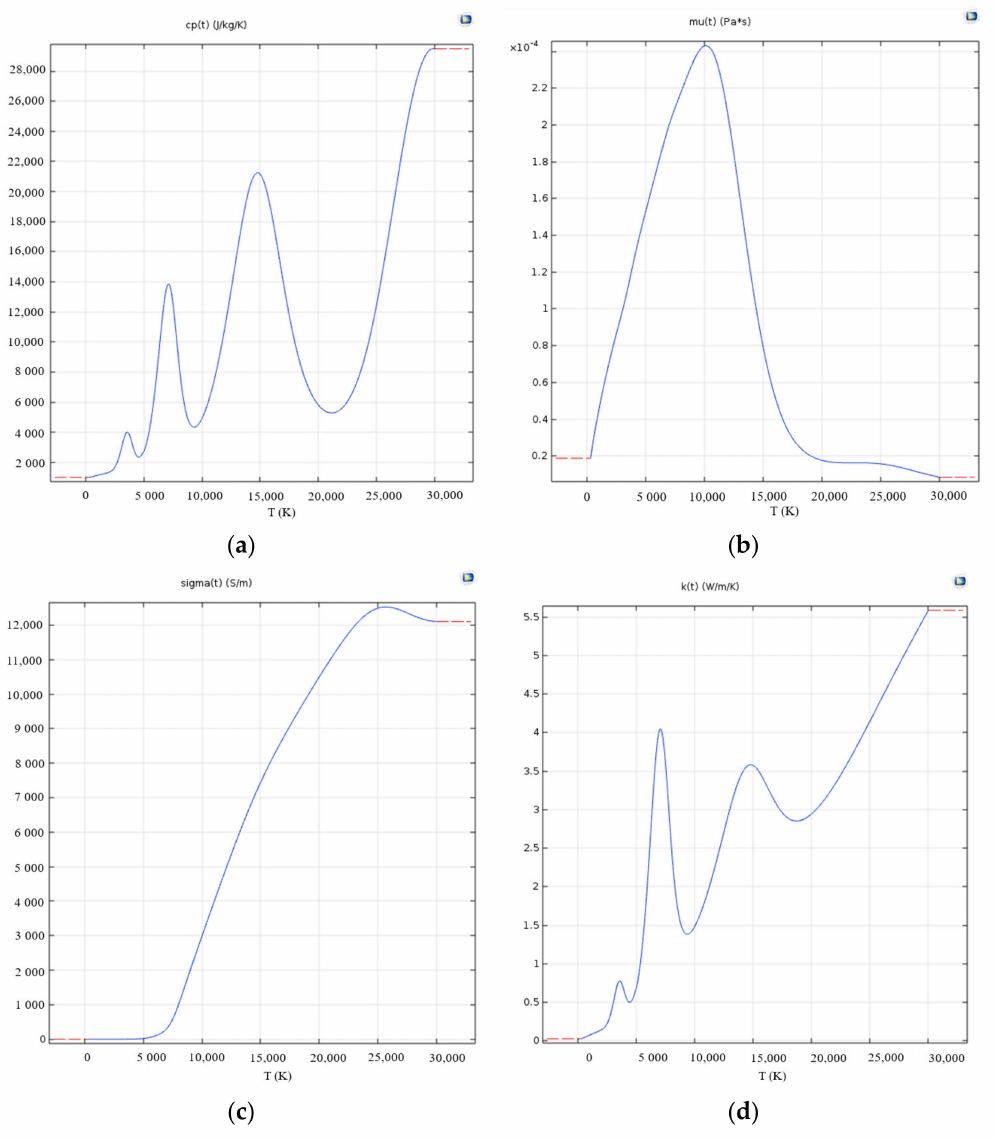
Figure 3. Arc parameter change curve with temperature. ( a ) The constant pressure thermal capacity of the arc curves with the temperature. ( b ) The dynamic viscosity of the arc curves with the temperature. ( c ) The electrical conductivity of the arc curves with the temperature. ( d ) The thermal conductivity of the arc curves with the